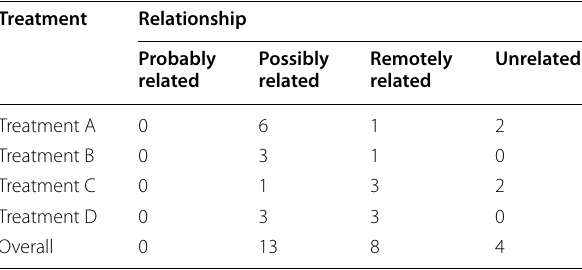
Table 7 Frequency of treatment‑emergent adverse events by